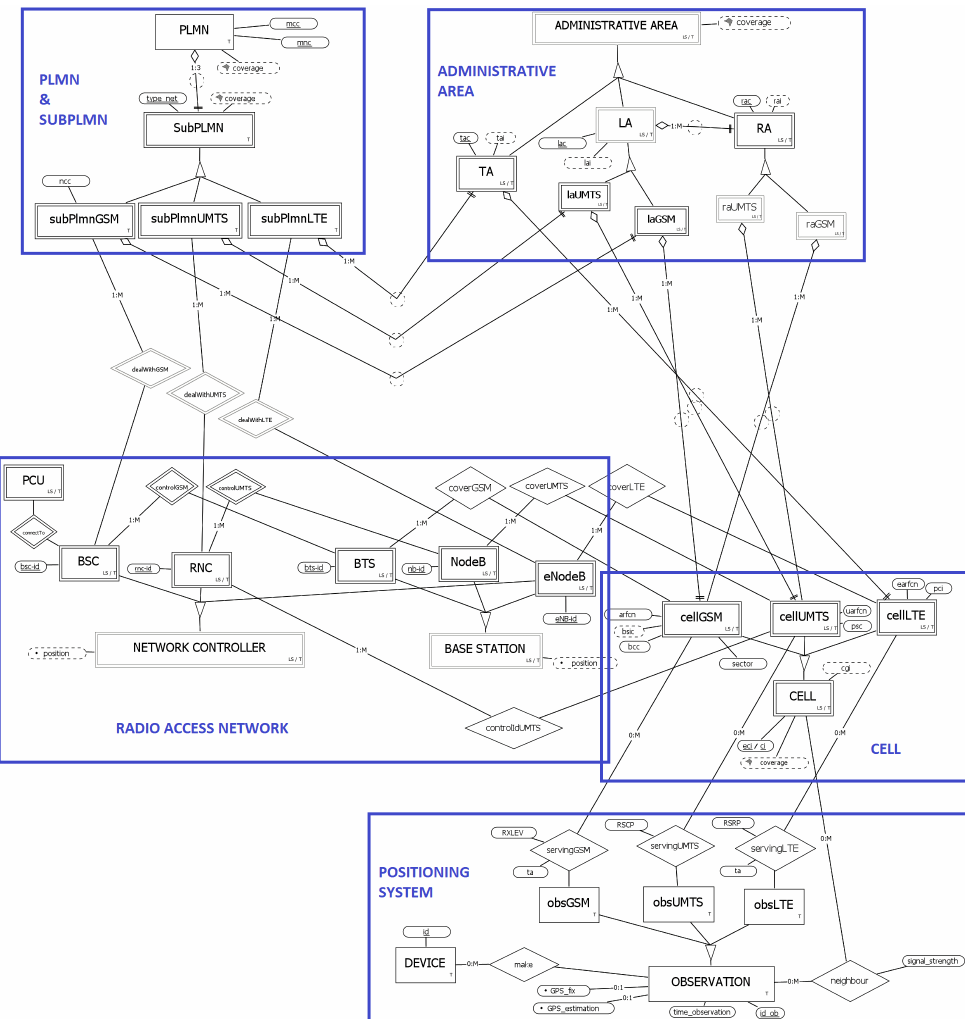
Figure 6. Complete cellular network schema, integrated with the part related to the positioning system and equipped with temporal support. T denotes entities that feature transaction time, whereas LS denotes instances that feature valid